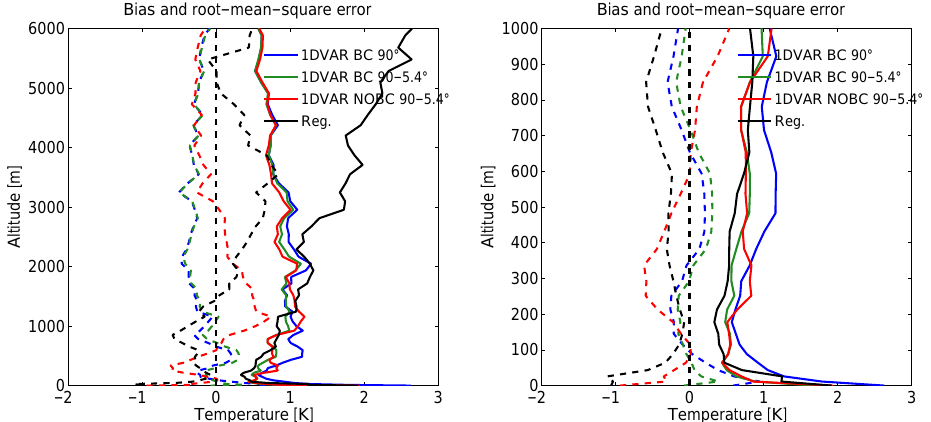
Figure 9. Vertical profiles of bias (dashed lines) and root-mean-square errors (solid lines) of MWR retrievals against radiosondes: 1DVAR retrievals from AROME 1h forecasts, all elevation angles and bias correction (green), all elevation angles but no bias correction (red), only zenith angle and bias correction (blue) and linear regressions (black). Results on 56 clear-sky temperature profiles.